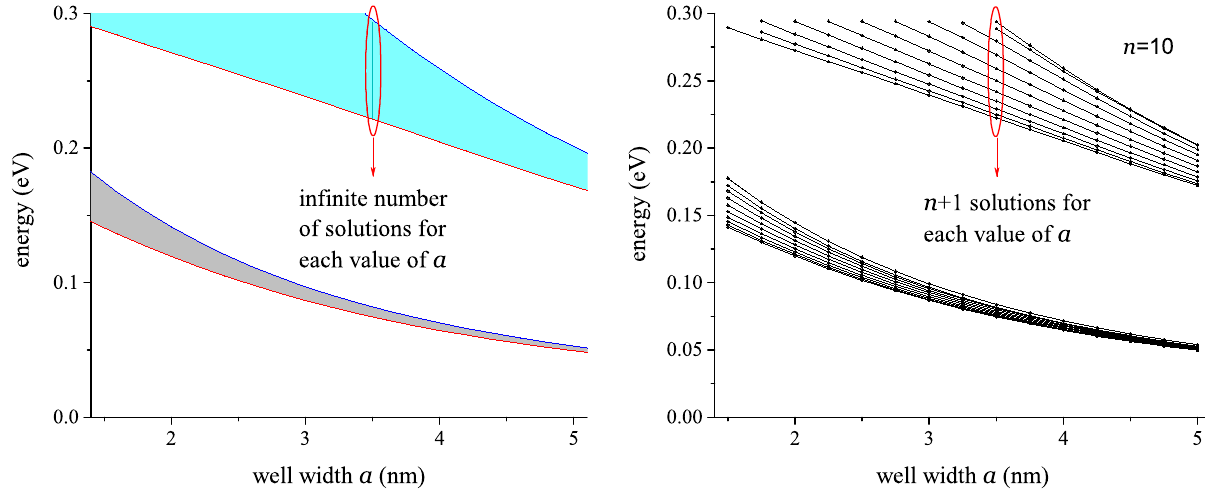
Figure 7. Band structure for a semiconductor superlattice ( GaAs / Al x Ga 1 − x As ) n with piecewise constant (rectangular) potential. In the left, the subband structure was calculated with the Kronig–Penney dispersion relation in (25) and in the dispersion relation in Section 4, the intraband energy levels calculated with the discrete dispersion relation in Equation (21). This figure was first published by the author in Ann. Phys. 397 , 159